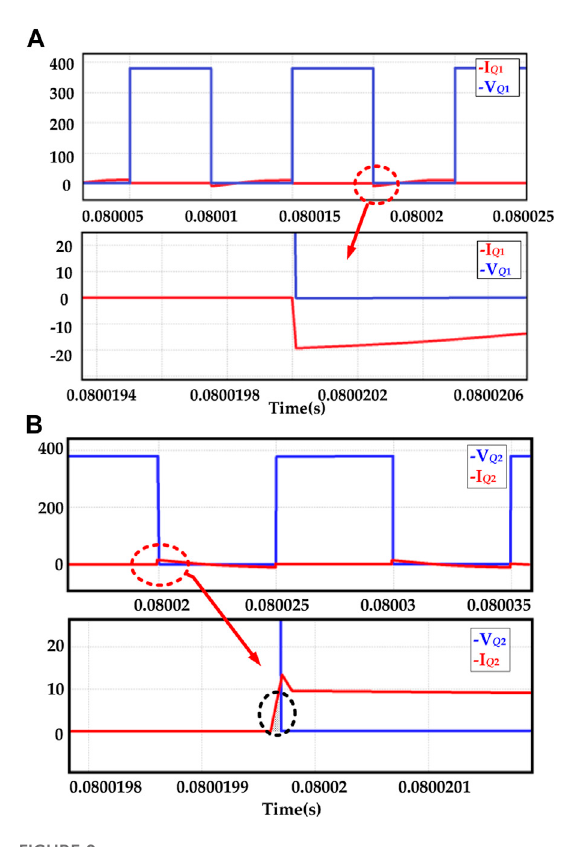
FIGURE 9 Current waveform and voltage waveform. (A) is waveform of Q 1 in WPT system without optimization; (B) is waveform of Q 2 in WPT system without